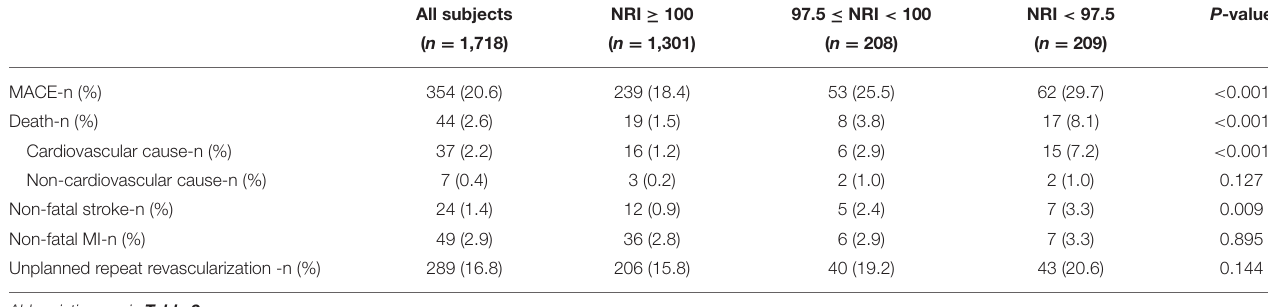
TABLE 1 | Clinical outcomes according to NRI degree during follow-up.